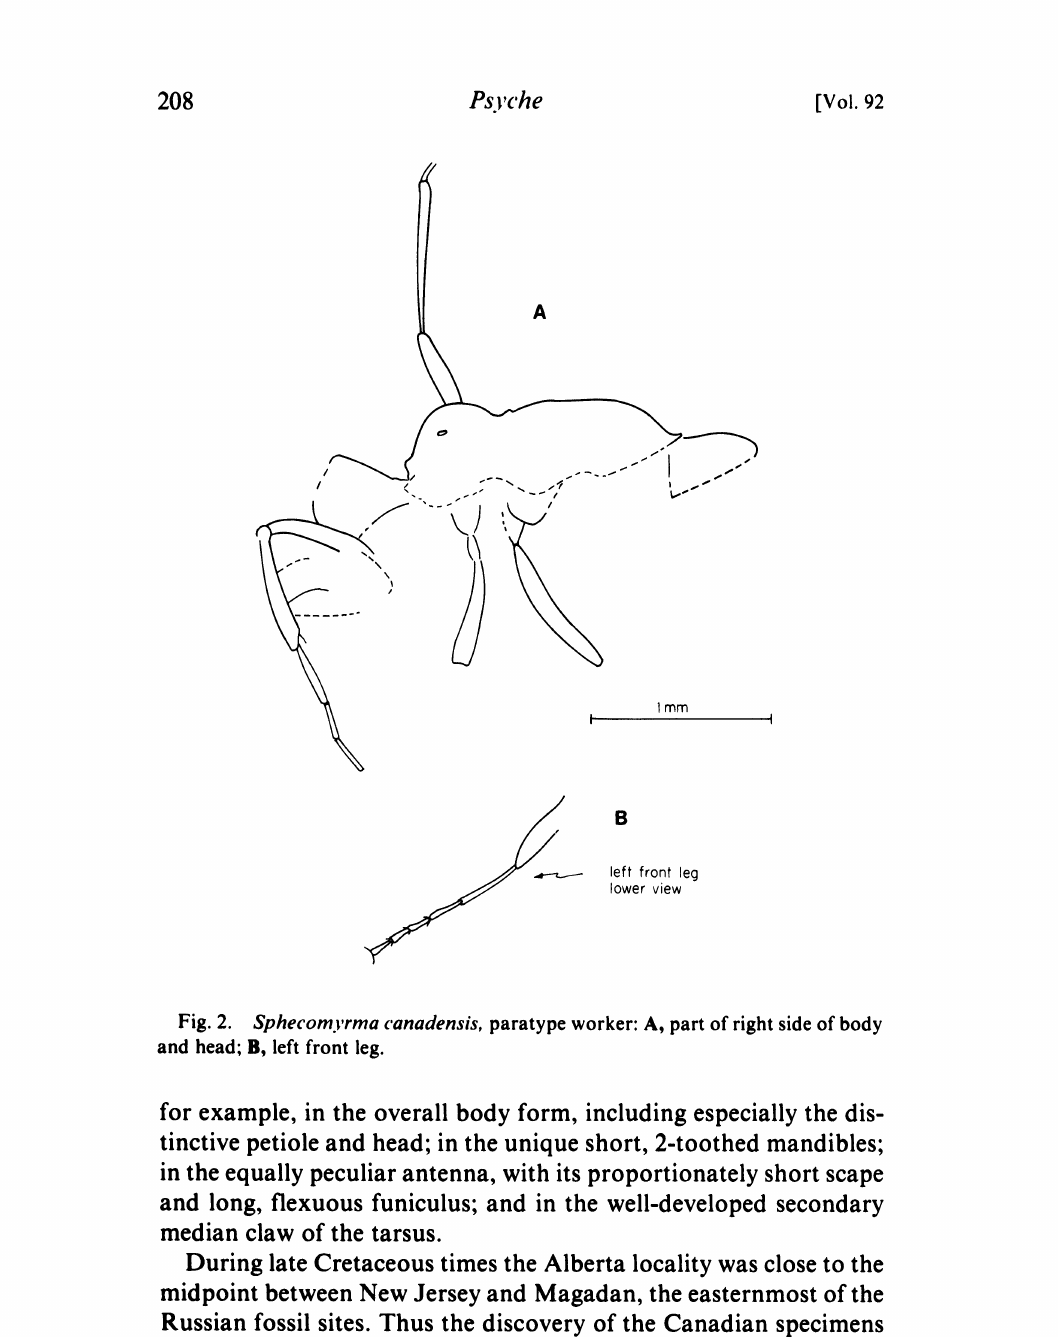
Fig. 2. Sphecomyrma canadensis, paratype worker: A, part of right side of body and head; !1, left front